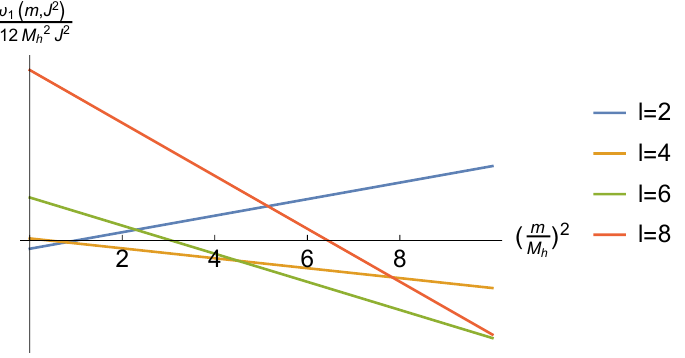
Figure 12 . Here we present the functional ω 1 ( m, J 2 ) for different spin. The position of the largest zero eq. (5.51) will increase as J 2